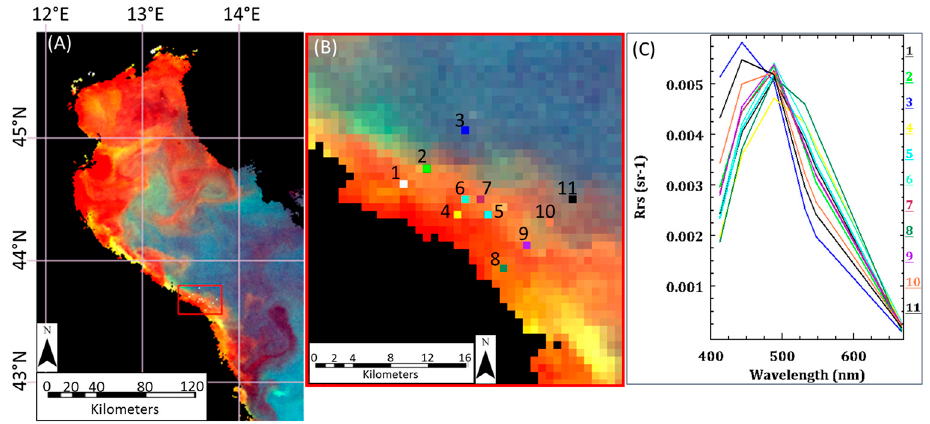
Figure 2. ( A ) Overview of MODIS R rs imagery (R: 547 nm; G: 488 nm; B: 443 nm) with the R rs spectra relative to the oceanographic cruises stations acquired in the Ancona coastal area (Italy) on 22 July 2015 shown in inset ( B ) as coloured dots (with the relative station number). Eastings and Northings are in geographic coordinates (latitude/longitude). ( C ) R rs spectra of the eleven measurement stations shown in ( B ) and represented with the same colour and number of the dots.